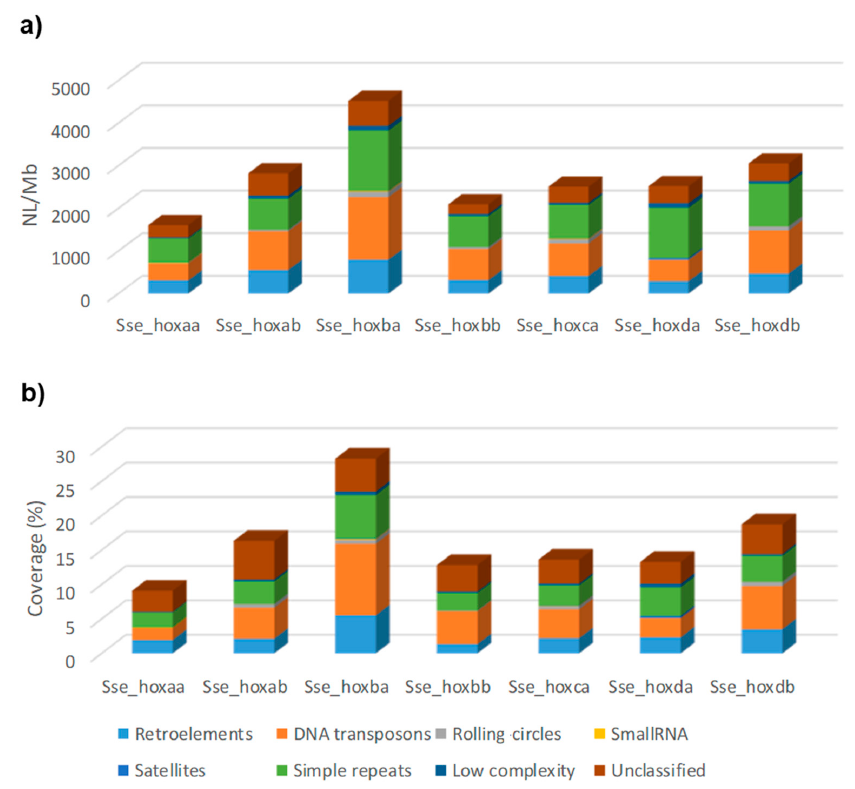
Figure 1. Number of loci per Mb ( a ) and coverage ( b ) of repetitive elements in seven hox clusters of the flatfish Solea senegalensis : Retroelements, DNA transposons, Small RNA, Rolling circles, Satellites, Simple repeats, Low complexity, and Unclassified repetitive sequences (Unknown). Coverage is measured as the percentage of length occupied by repeated elements.